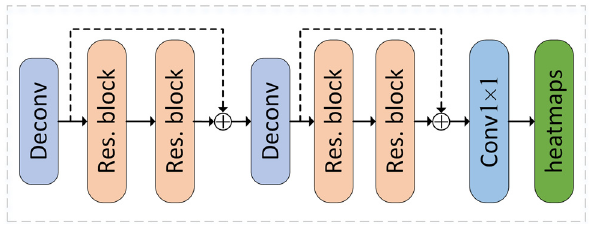
Figure 4: The re fi ned network.